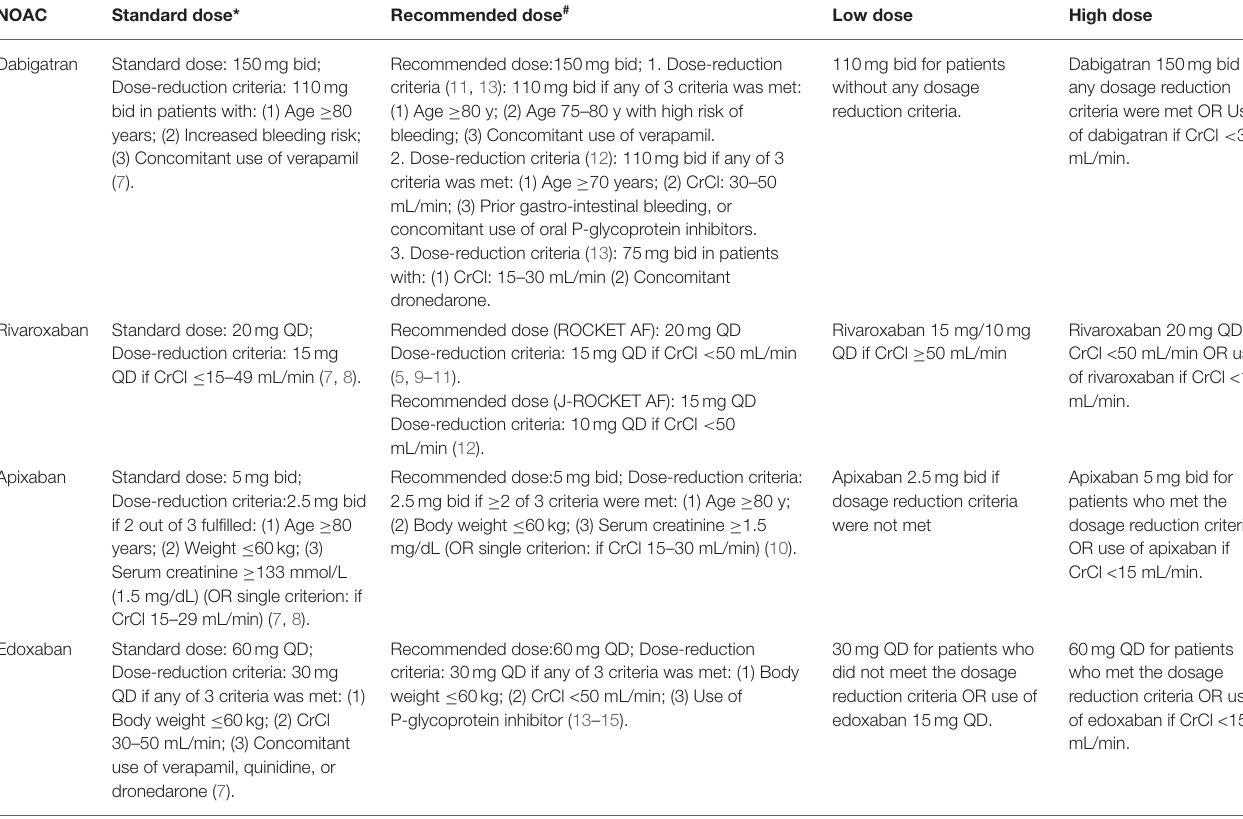
TABLE 1 | The definitions of recommended/low/high NOACs dosage. NOAC Standard dose* Recommended dose # Low dose High dose